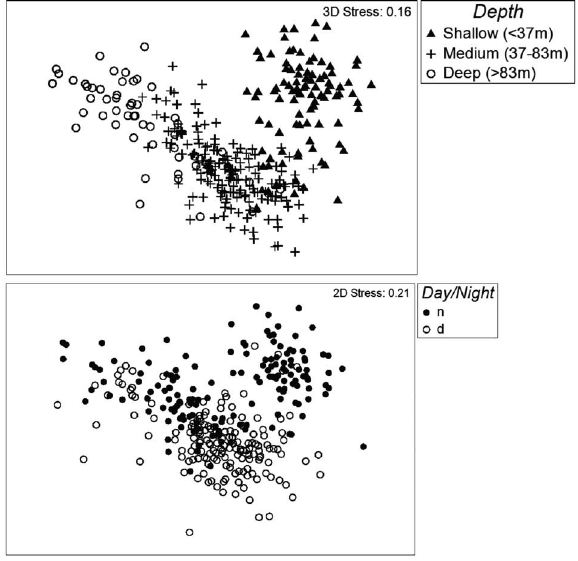
Fig . 5. – MDS of the species composition of 324 haul samples ac- cording to haul depth (top) and time of day (bottom); n, night; d,